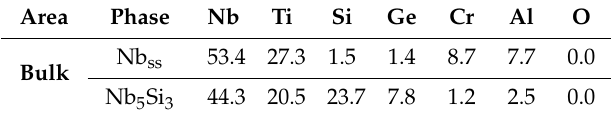
Figure 8. BSE image showing typical microstructures of a cross-section of the alloy ZF6 after oxidation in air at 800 °C for 100 h. Table 5. The composition (at.%) of the constituent phases in the bulk of the oxidised alloy ZF6.